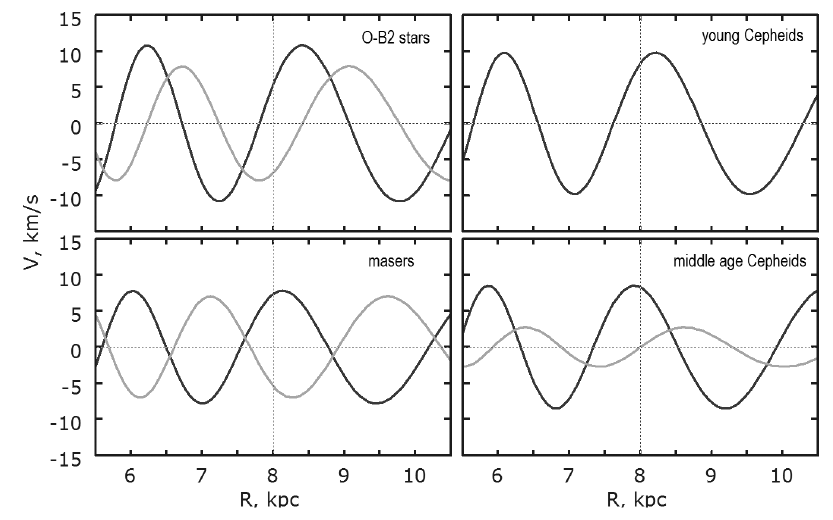
Fig. 1. Radial ( V R , dark) and tangential (∆ V θ , light) perturbation velocities versus Galactocentric distances R . The dotted line indicates the location of the